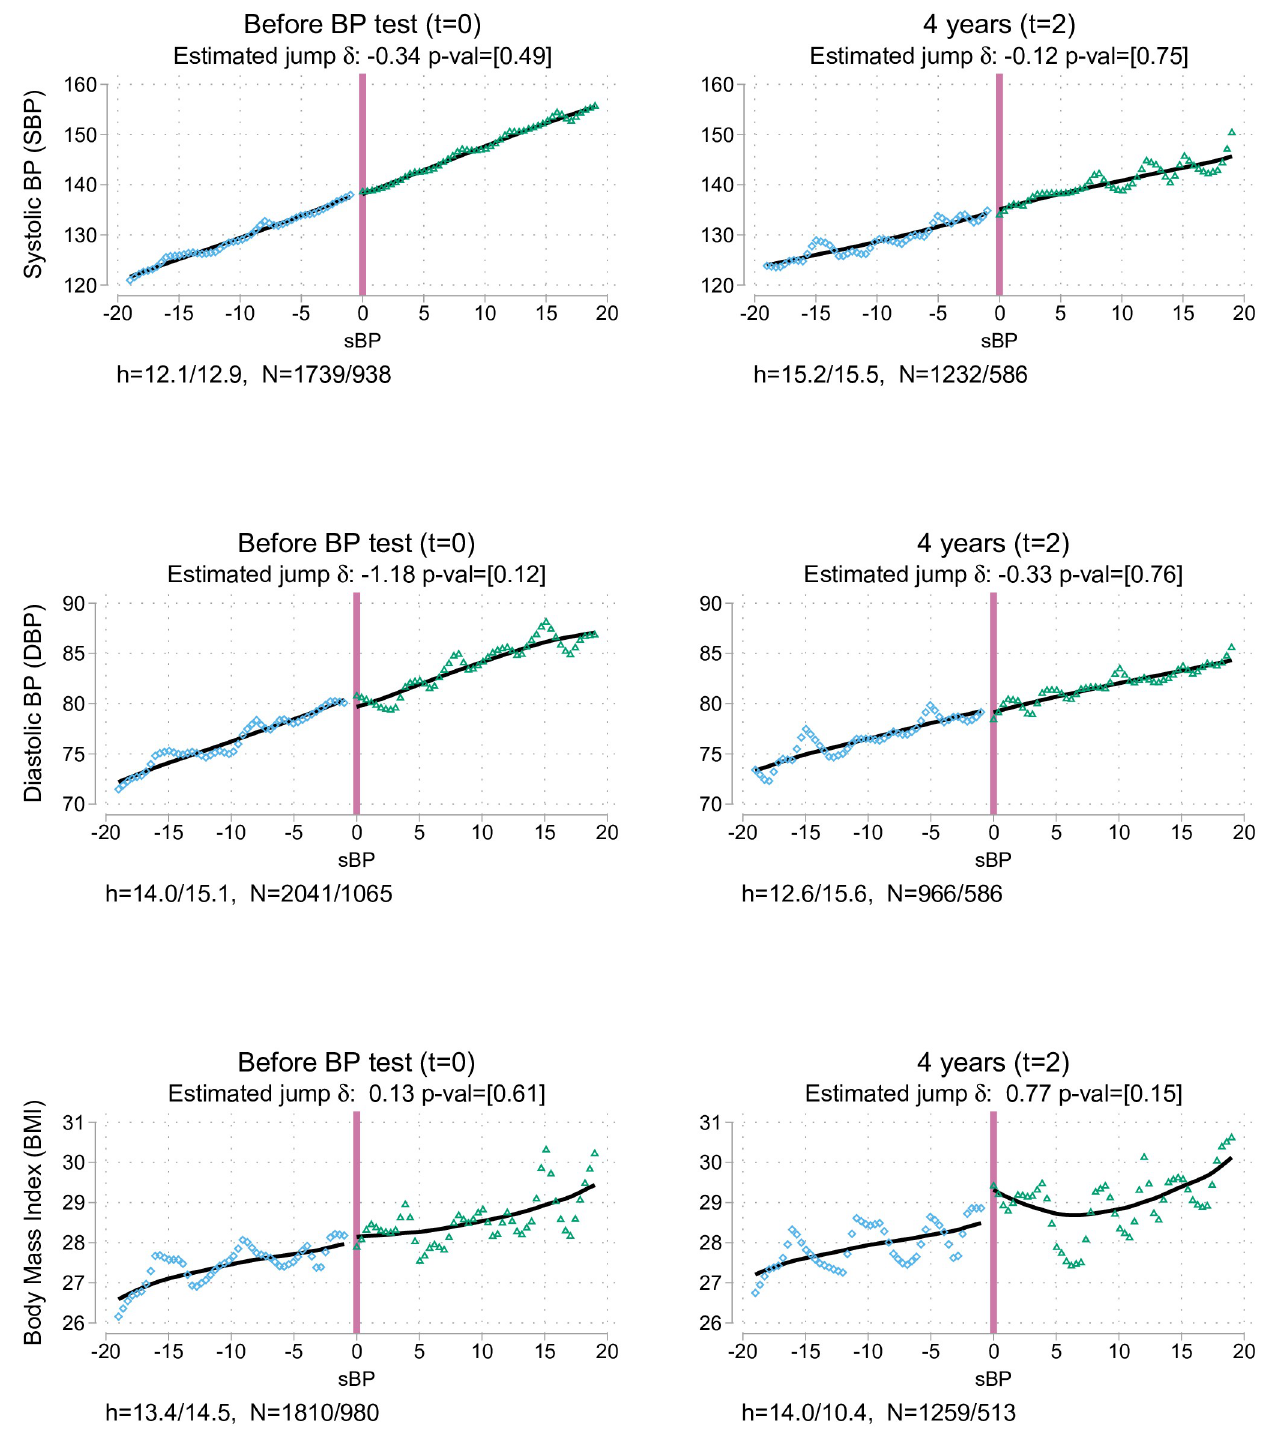
Fig 4. Impacts on